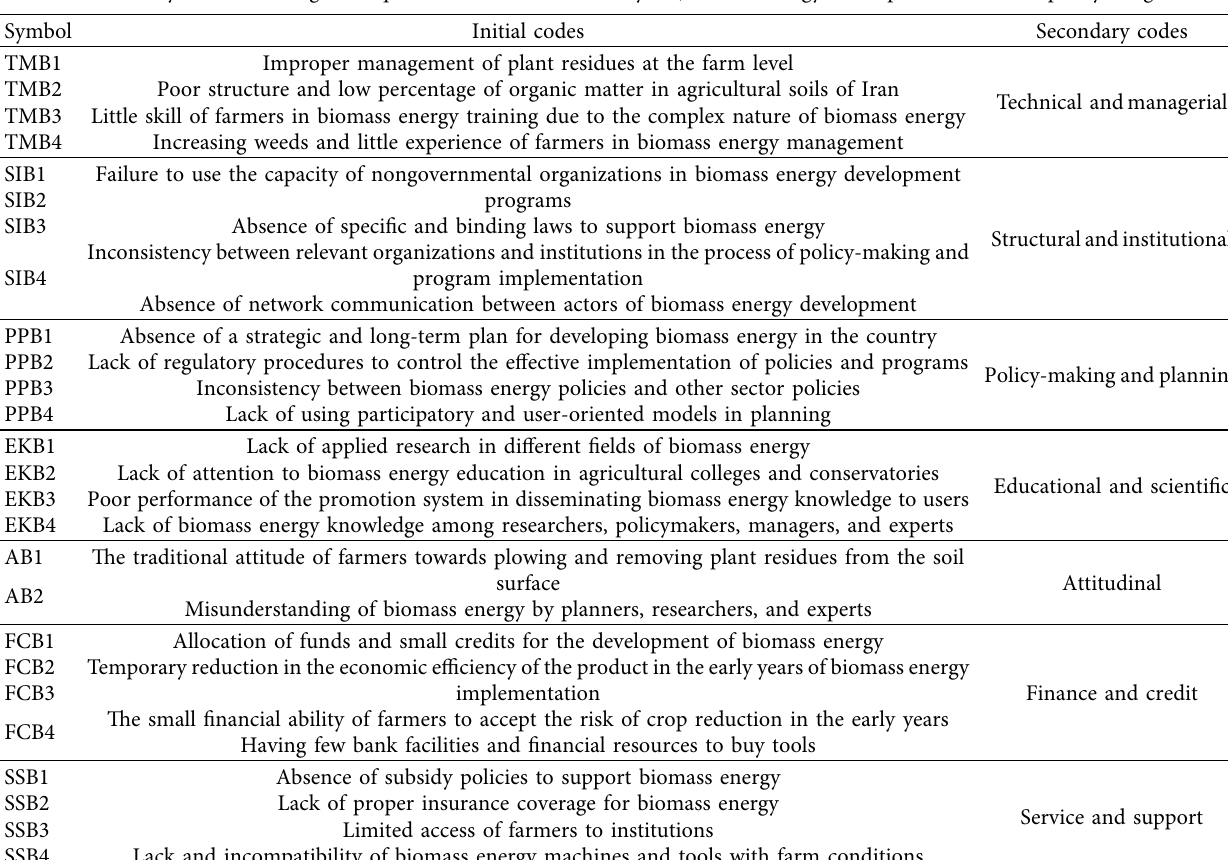
Table 3: Secondary codes resulting from qualitative data content analysis (biomass energy development education policy in agriculture). Symbol Initial